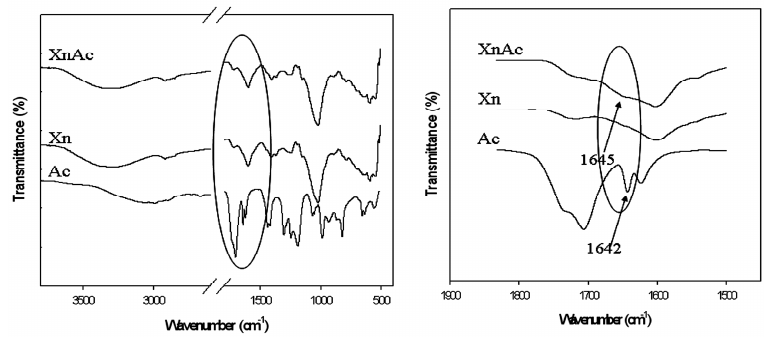
Figure 2. 1 H-NMR spectra of Xn and XnAc polymers.